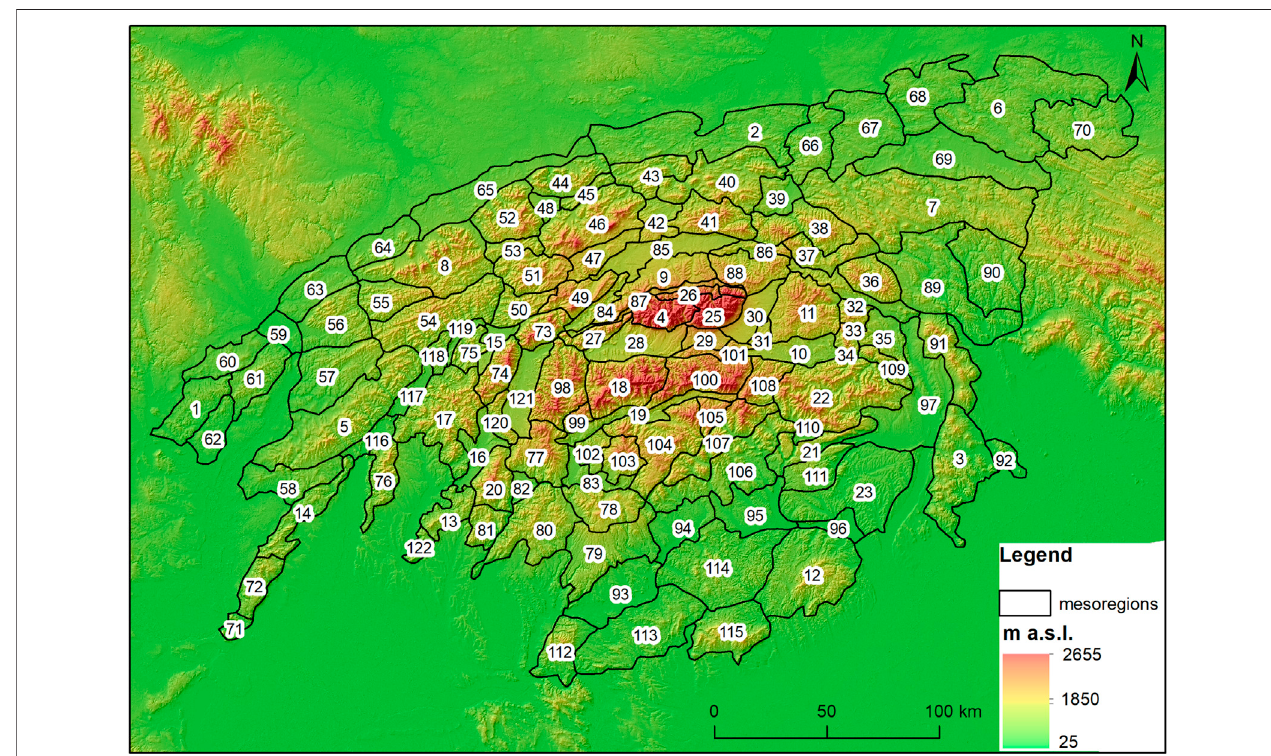
FIGURE2| ThemesoregionsofWesternCarpathians.Source: Balon et al.,2019.1: Ž dánickýles Plateau, 2:PogórzeWielickie Range,3: Zempléni hegység Mts., 4: Western Tatra Mts., 5: Biele Karpaty Mts., 6: Pogórze Dynowskie Range, 7: Beskid Niski Mts., 8: Moravskosliezske Beskydy Mts., 9: Fore-Tatra Foothills, 10: Hornadska kotlina Basin, 11: Levo č ské vrchy Mts., 12: Bükk hegység Mts., 13: Ve ľ ký Tríbe č Mts., 14: Malé Karpaty Č achtické Mts., 15: Ž ilinská kotlina Basin, 16: Hornonitrianska kotlina Basin, 17: Strá ž ovské vrchy Mts., 18: Nízke Tatry- Ď umbierske Tatry Mts., 19:Horehronské podolie Basin, 20: Vtá č nik Mts., 21: Zádielska dolina Valley, 22: Volovské vrchy Mts., 23: Bodvianska pahorkatina Range, 24: Belianske Tatra Mts., 25, High Tatra Mts., 26 Reglowe Tatra Mts., 27: Cho č ské vrchy Mts., 28: Liptovská kotlina Basin, 29: Š trbský prah Range, 30: Popradská kotlina Basin, 31: Wierzbow Range, 32: Spi š sko- š ari š ské medzihorie Upland, 33: Bachure ň Range, 34: Branisko Range, 35: Š ari š ske podhorie Range, 36: Č ergov Mts., 37: Pogórze Popradzkie Range, 38: Beskid S ą decki Mts., 39: Kotlina S ą decka Basin, 40: Beskid Wyspowy Mts., 41Gorce Mts., 42, Pogórze Orawsko-Jordanowskie Range, 43: Beskid Ś redni Mts., 44: Beskid Ma ł y Mts., 45: Pasma Pewelsko-Krzeczowskie Range, 46: Beskid Ż ywiecko-Orawski Mts., 47: Dzia ł y Orawskie Range, 48: Kotlina Ż ywiecka Basin, 49: Oravská Magura Mts., 50: Kysucká vrchovina Range, 51: Beskid Ż ywiecko-Kysucki Mts., 52: Beskid Ś l ą ski Mts., 53: Mi ę dzygórze Jab ł onkowsko-Koniakowskie Upland, 54: Javorníky Mts., 55: Vsetínské vrchy Mts., 56: Hostýnské vrchy Mts., 57: Vizovická vrchovina Mts., 58: Myjavska pahorkatina Range, 59: Hornomoravský úval Basin, 60: Liten č ická pahorkatina Range, 61: Ch ř iby Mts., 62: Kyjovská pahorkatina Range, 63: Podbeskydská pahorkatina Range, 64: Ji č ínská pahorkatina Mts., 65: Pogórze Ś l ą skie Range, 66: Pogórze Ro ż nowskie Range, 67: Pogórze Ci ęż kowickie Range, 68: Pogórze Strzy ż owskie Range, 69: Do ł y Jasielsko-Sanockie Basin, 70: Pogórze Przemyskie Range, 71: Malé Karpaty Brezovské Mts., 72: Malé Karpaty Devínske Mts., 73: Krivánska Fatra Mts., 74: Lú č anská Fatra, 75: Sú ľ ovské skaly Mts., 76: Góry I ł owieckie Mts., 77: Kremnické vrchy Mts., 78: Javorie Range, 79: Krupinská planina Range, 80: Š tiavnické vrchy Mts., 81: Pohronský Inovec Range, 82: Ž iarská kotlina Basin, 83: Zvolenská kotlina Basin, 84: Oravská kotlina Basin, 85: Kotlina Orawsko-Nowotarska Basin, 86: Pieniny Mts., 87: Sub-Tatra Basin, 88: Magura Spiska Range, 89: Ondavská vrchovina Range, 90: Laborecká vrchovina Range, 91: Slanské vrchy Mts., 92: Pagóry Zempli ń skie Range, 93: Ipe ľ ská kotlina Basin, 94: Lu č enská kotlina Basin, 95: Rimavská kotlina Basin, 96: Borsodi-medence Basin, 97: Ko š ická kotlina Basin, 98: Ve ľ ká Fatra Mts., 99: Starohorské vrchy Mts., 100: Nízke Tatry-Krá ľ ovoho ľ ské Tatry Mts., 101: Kozie chrbty Mts., 102: Bystricka vrchovina Range, 103: Polána Range, 104: Veporské vrchy Mts., 105: Muránska planina Range, 106: Revúcka vrchovina Range, 107: Stolické vrchy Mts., 108: Slovenský raj Mts., 109: Č erná hora Mts., 110: Ro žň avská kotlina Basin, 111: Slovenský a Aggtelecký kras Range, 112: Börzsöny hegység Range, 113: Cerová vrchovina Range, 114: Cerov Mts., 115: Matra Mts., 116: Tren č ianská kotlina Basin, 117: Ilavská kotlina Basin, 118: Podmanínska pahorkatina Hillyland, 119: Byt č a Basin, 120: Ž iar Mts., 121: Tur č ianska kotlina Basin, 122: Malý Tríbe č